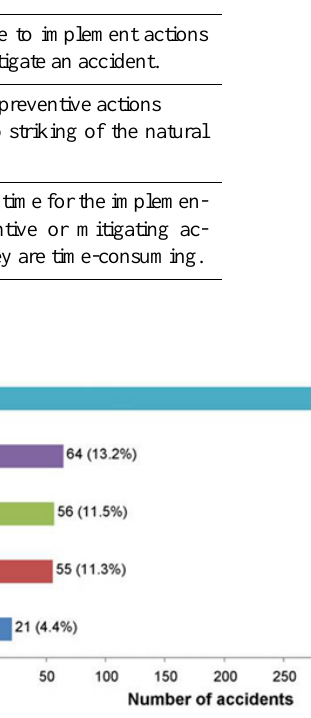
Fig. 3. Main equipment types involved in lightning-triggered Nat- ech accidents (analysis based on 485 accidents) (Renni et al.,